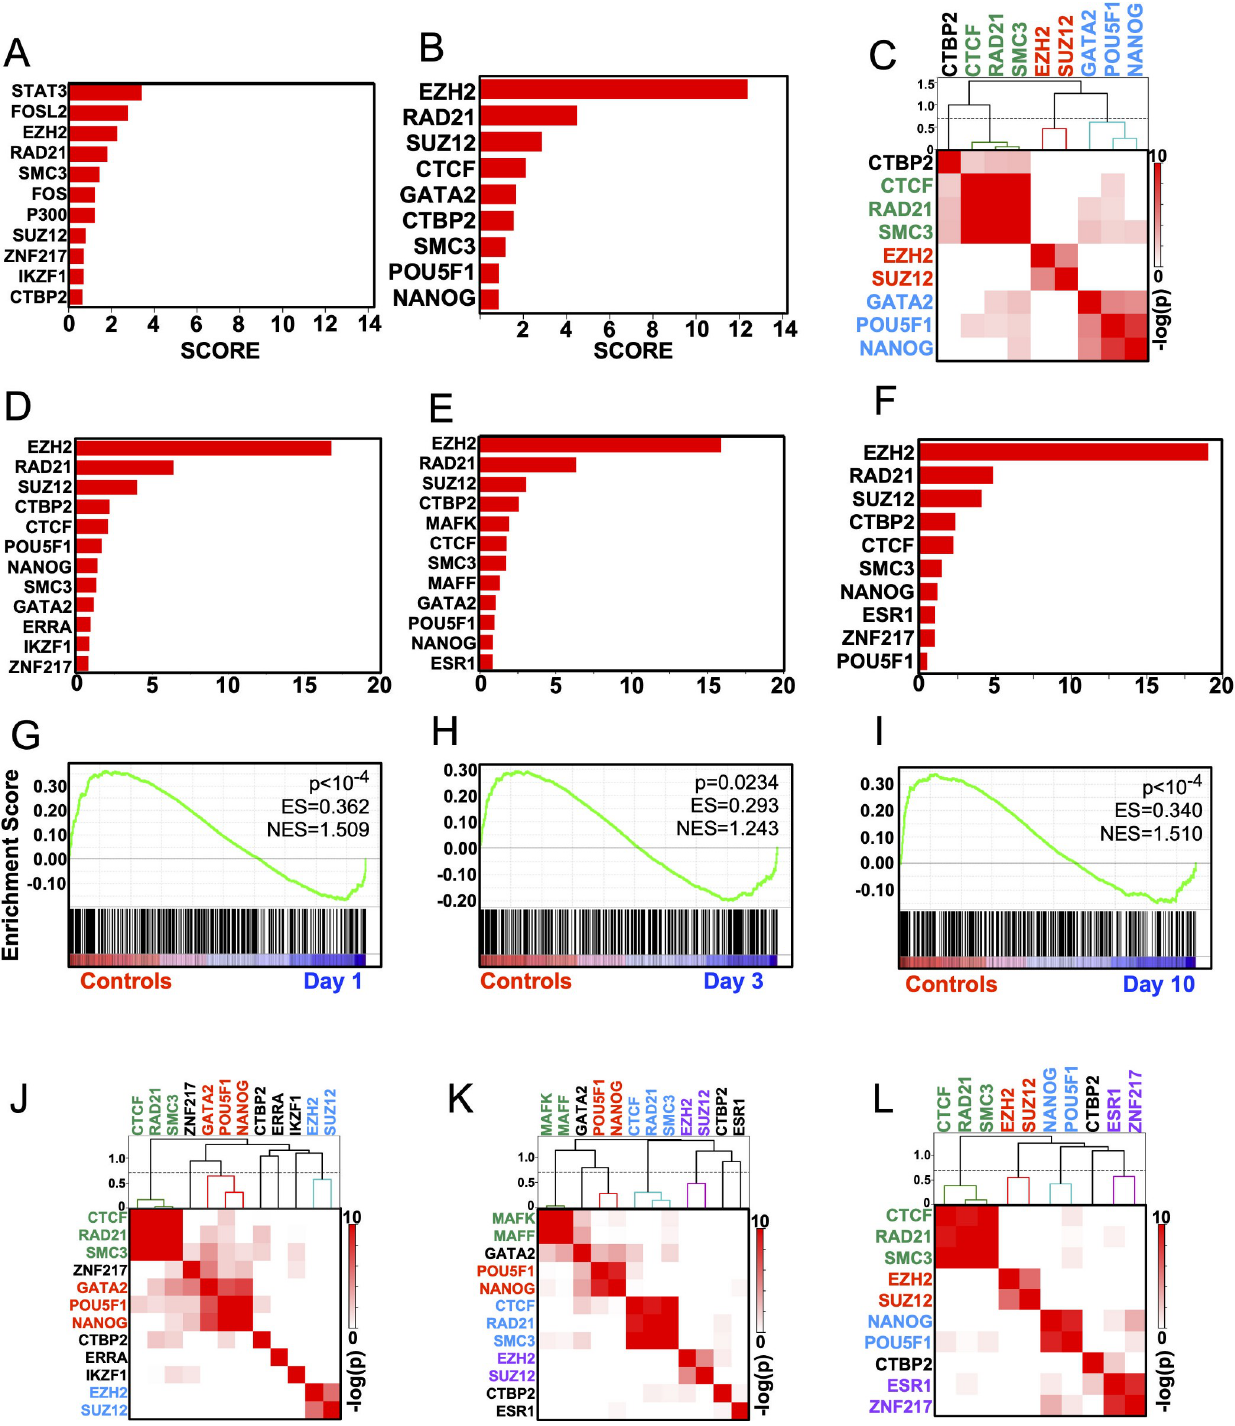
Fig 2. EZH2 drives gene change repression in the early latent period. A) Genes upregulated at both days 1 and 10 are enriched for STAT3 ChIP peaks across ENCODE ChIP-seq profiles. B) Persistently repressed genes are enriched for EZH2 peaks across ENCODE ChIP-seq profiles. C) Overlaps between lists of target genes for each significant Factor are plotted as a heatmap based on Fisher Exact test p values. Clustering by Pearson distance highlights 3 groups of factors controlling persistently repressed genes. Dashed line cutting branches of the hierarchy tree at Pearson distance = 0.7 (Pearson correlation = 0.3). D-F) Factor analysis highlights EZH2 as the principle driver of repression 1d, 3d or 10d post SE. G-I) GSEA shows EZH2 target genes are enriched in control samples and depleted in repressed genes 1d, 3d or 10d post SE. J-L) Fisher Exact tests of driven genes 1d, 3d or 10d post SE shows EZH2 and SUZ12 co-target genes at all 3